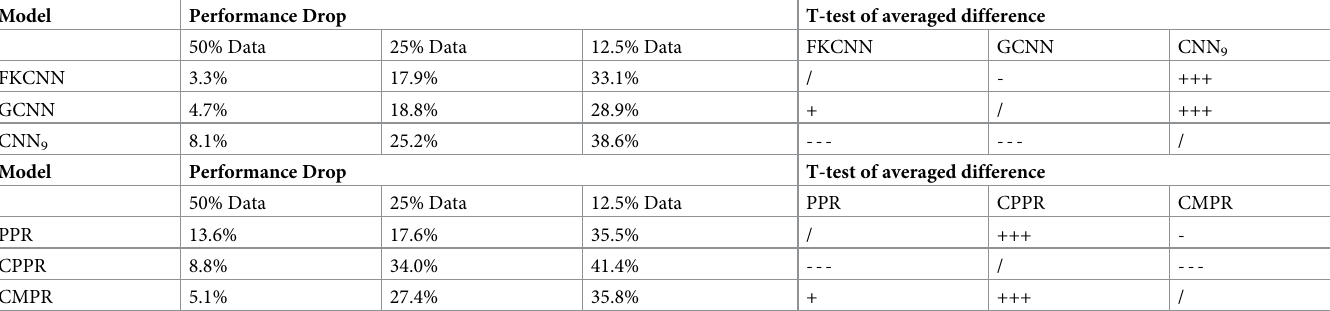
Table 2. The performance drop when using less data on Monkey A. For statistical significance, we adopt the same notation from Table 1. Model